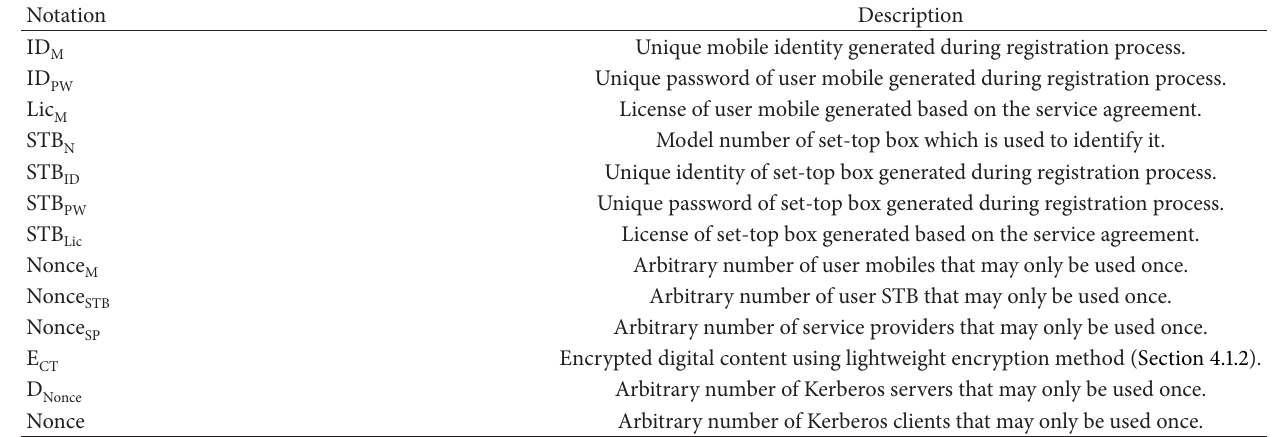
Table 1: Table system parameters.